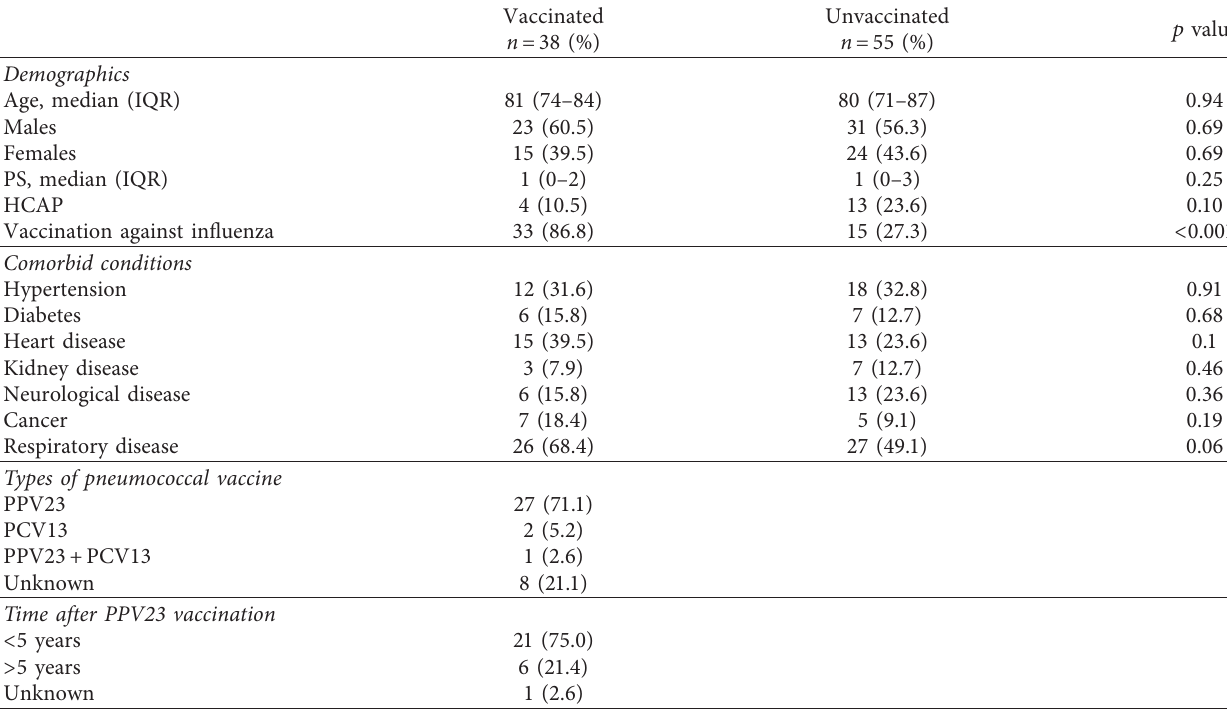
Table 1: Patient